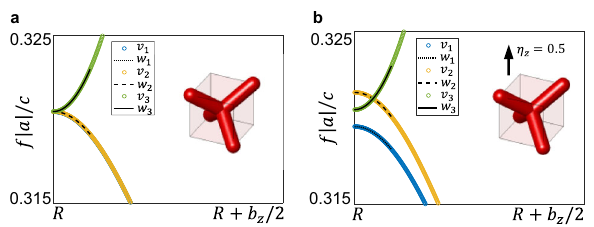
Fig. 6 Comparison of the numerical band-dispersion with the analytical model. Extracting the coef fi cients of the analytical k ⋅ p model in the vicinity of R . Here, we are considering an extrapolation of the model at a distance of δ k = 0.008 from R . The empty circles are for numerical computed bands v 1,2,3 while the lines for the analytical dispersion w 1,2,3 . a In presence of TRS, we conclude that b 0 = − 2.9 a 0 > 0. b In a weak fi eld η = 0.5, we obtain that α − β α 0 ~ 0 since the third band does not move in energy and 0 ~ 0 since the ffiffiffiffiffiffiffiffiffi q vertical displacement of the two lowest degenerate modes is equal and j δ 0 B z j opposite. Weyl points appear at positions: k ± ¼ ± , which here is at z b 0 ¼ ± 0 : 004. The δ 0 B z > 0 and δ 0 B z < 0 cases are equivalent upon k ± z reversing the two lowest photonic modes. Source data are provided as a Source Data fi le.